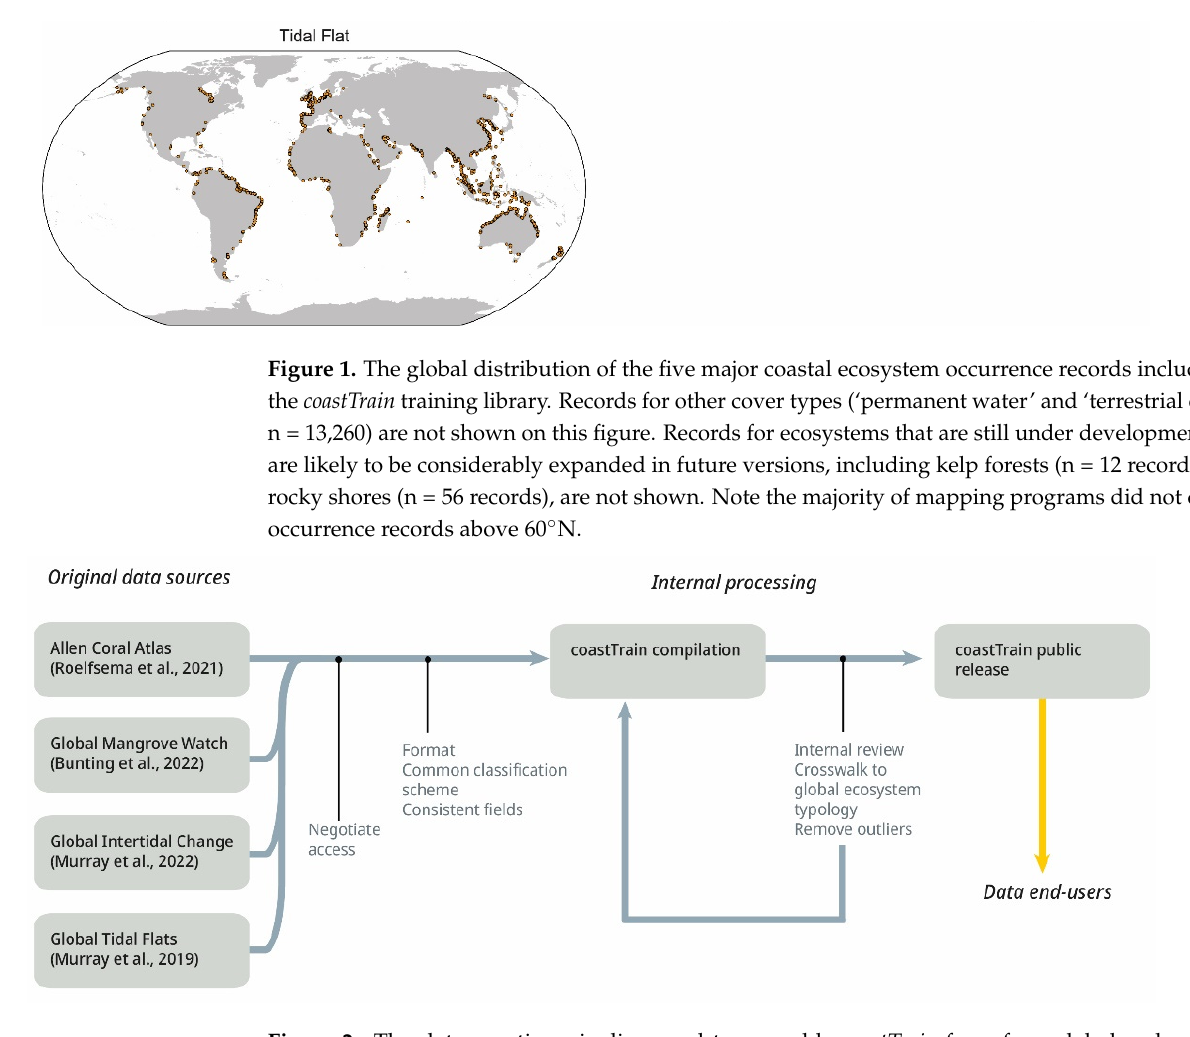
Figure 2. The data curation pipeline used to assemble coastTrain from four global-scale coastal ecosystem mapping initiatives (left). A subset or all of the training data is submitted to the coastTrain processing pipeline, formatted to a common data format with consistent classification scheme and compiled into a version of the database. A data validation and cross-walking sub-component is ap- plied, and a versioned release is made available to users via an open-access data repository [7,10– 12].